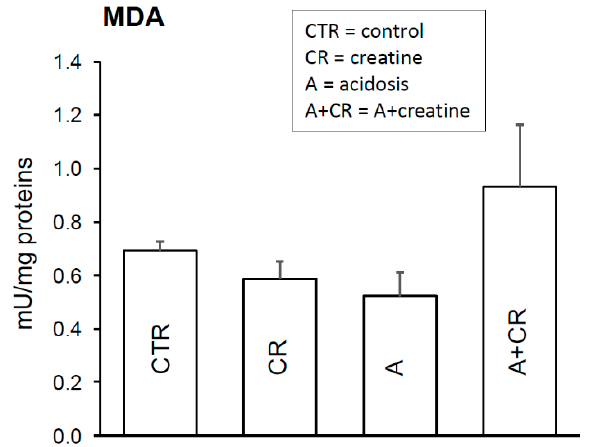
Figure 4. E ff ects of 11 d administration of 20 mM creatine on malondialdehyde (MDA) production of jejunal mucosal homogenate under control conditions and chronic acidosis. Values are means ± S.E. Number of experiments = 4 with duplicate estimation.